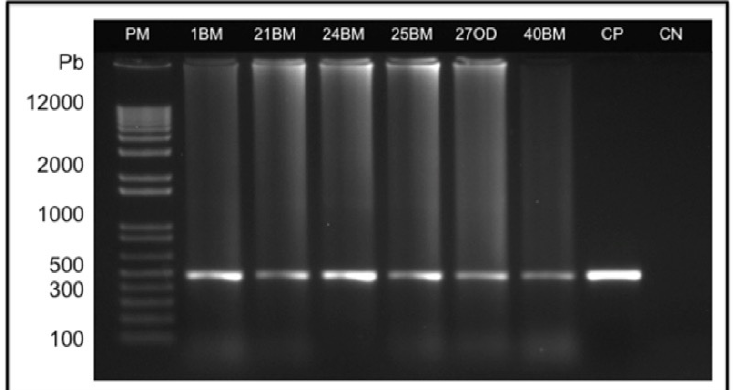
Figure 1. Agarose gel showing bands corresponding to the amplification of the PCR product specific for M. bovis from DNA extracted from lesions suggestive of bovine tuberculosis, obtained in slaughterhouses under SIF, during post-mortem inspection. PM: standard molecular size 1kb Plus DNA Ladder (Invitrogen). CP: positive control. CN: negative